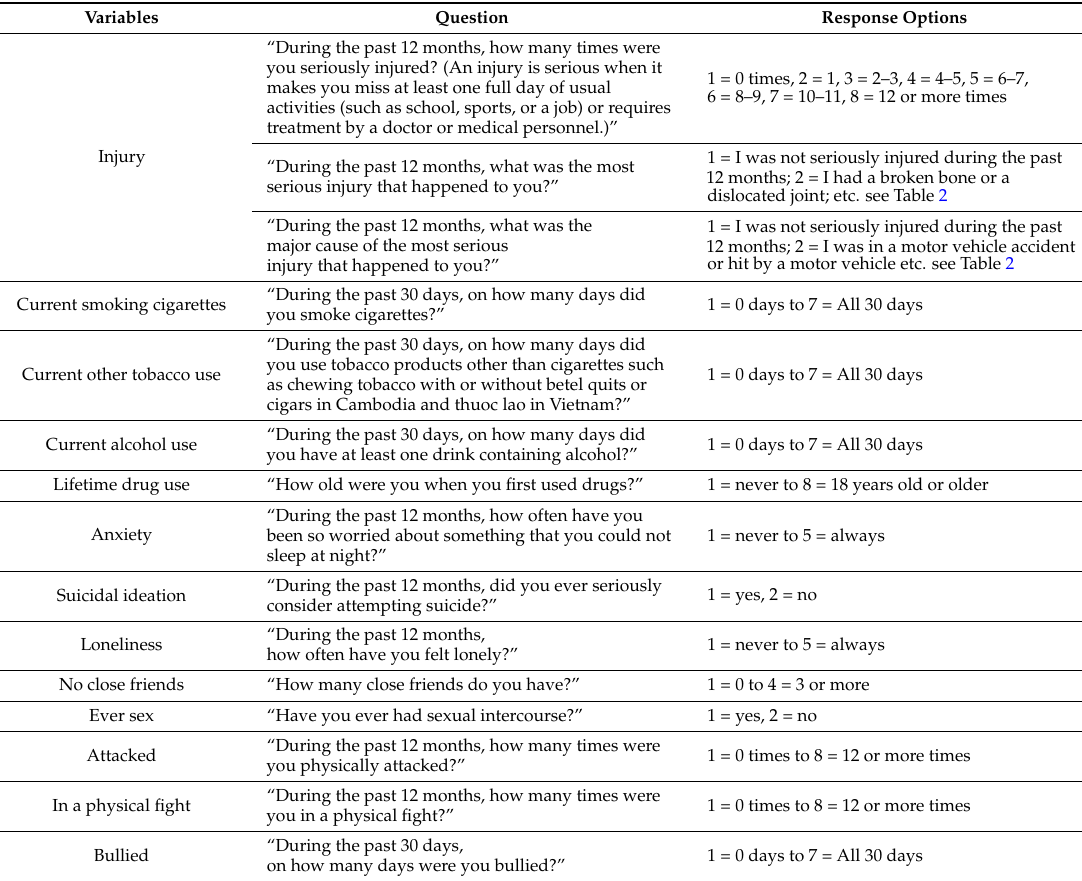
Table 1. Variable